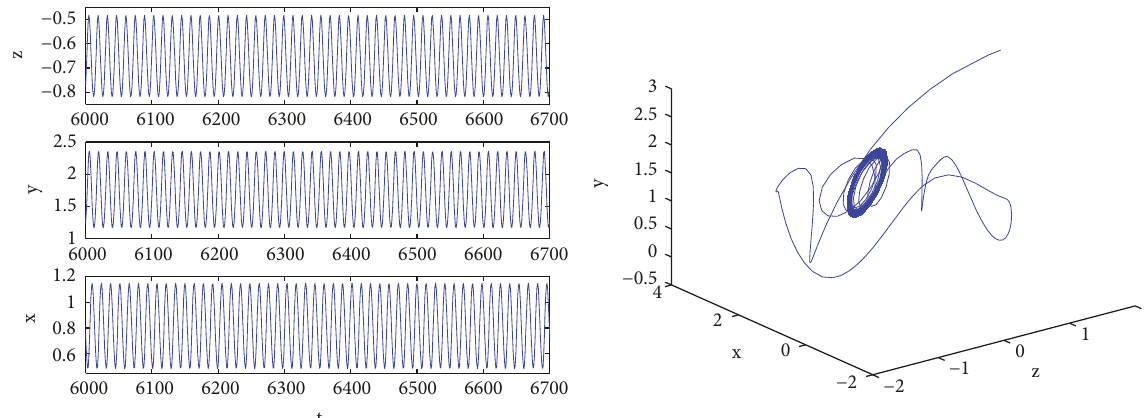
Figure 10: E ∗ + is unstable, and a periodic solution appears with 𝜏 1 = 0.1 and 𝜏 2 = 3.9